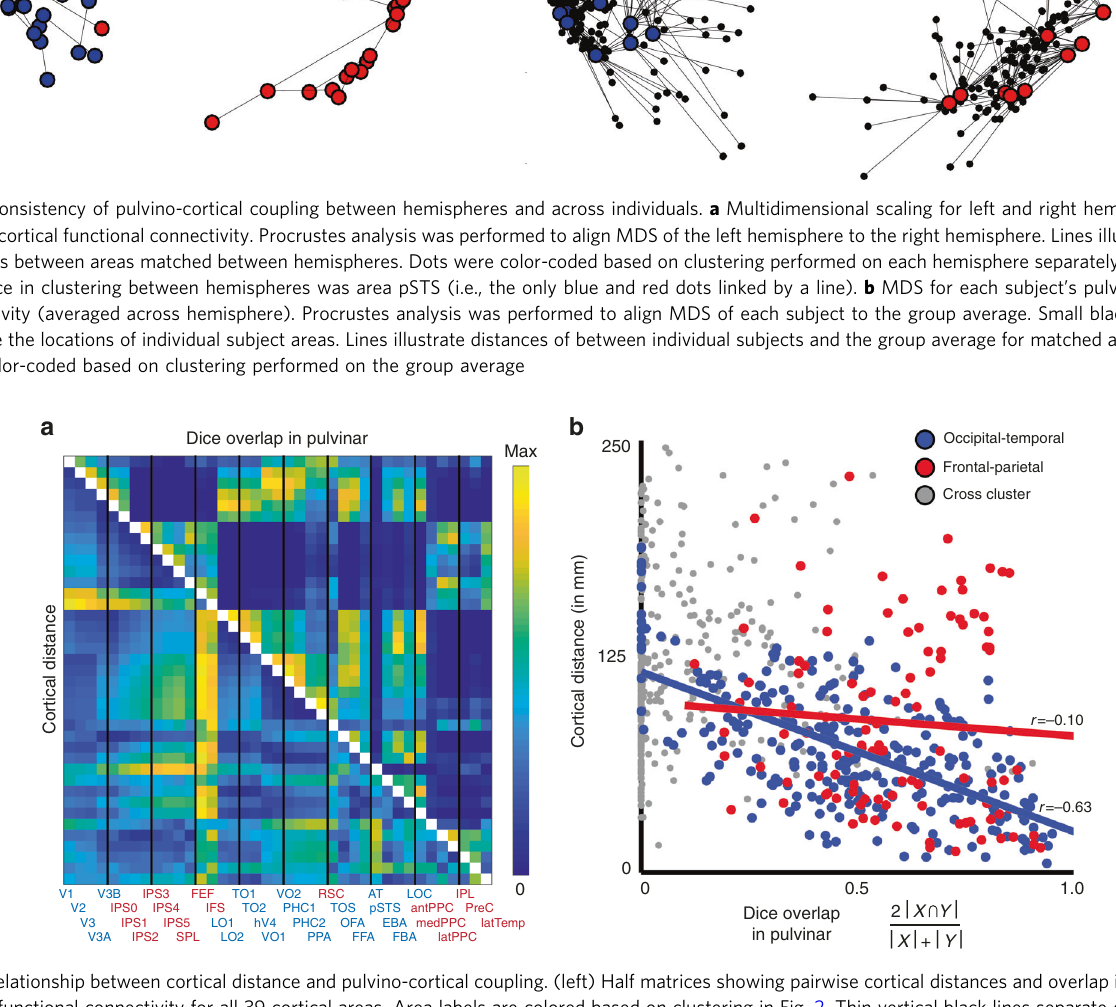
between cortically distant areas such as IPS2 in parietal cortex and FEF in frontal cortex. The foci of these correlations were situated just medial to the lateral edge of the dorsal pulvinar. In contrast, the pulvino-cortical connectivity maps of other dorsal areas appeared to be spatially distinct. For example, the foci of